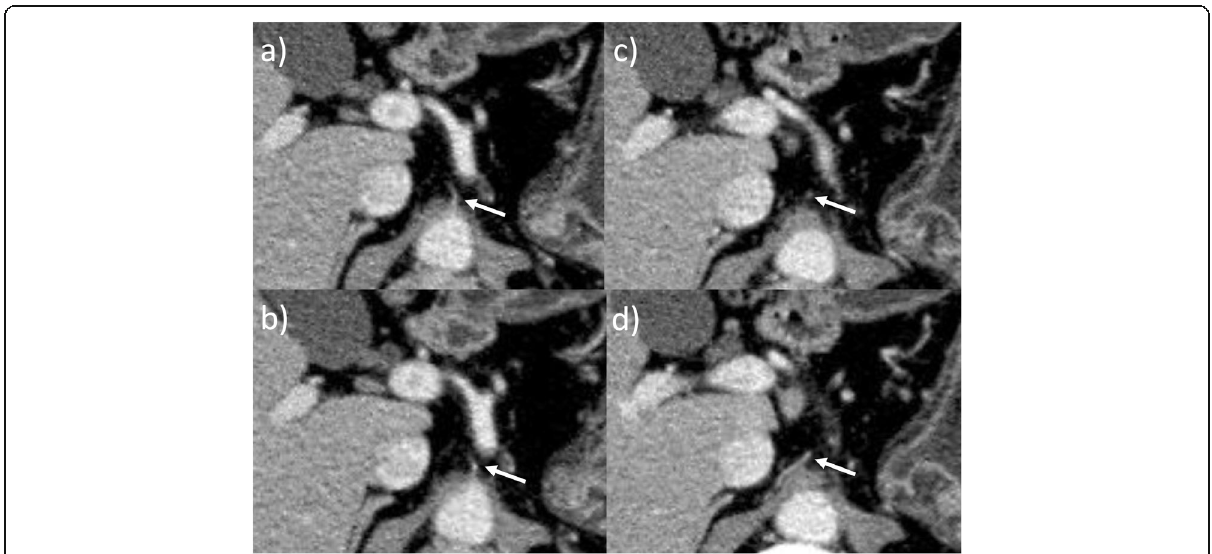
Fig. 4 Preoperative CT. a The RIPA (arrow) originated from the aorta without a common trunk. b , c The RIPA ran close to the celiac artery. d The RIPA ran across and in front of the